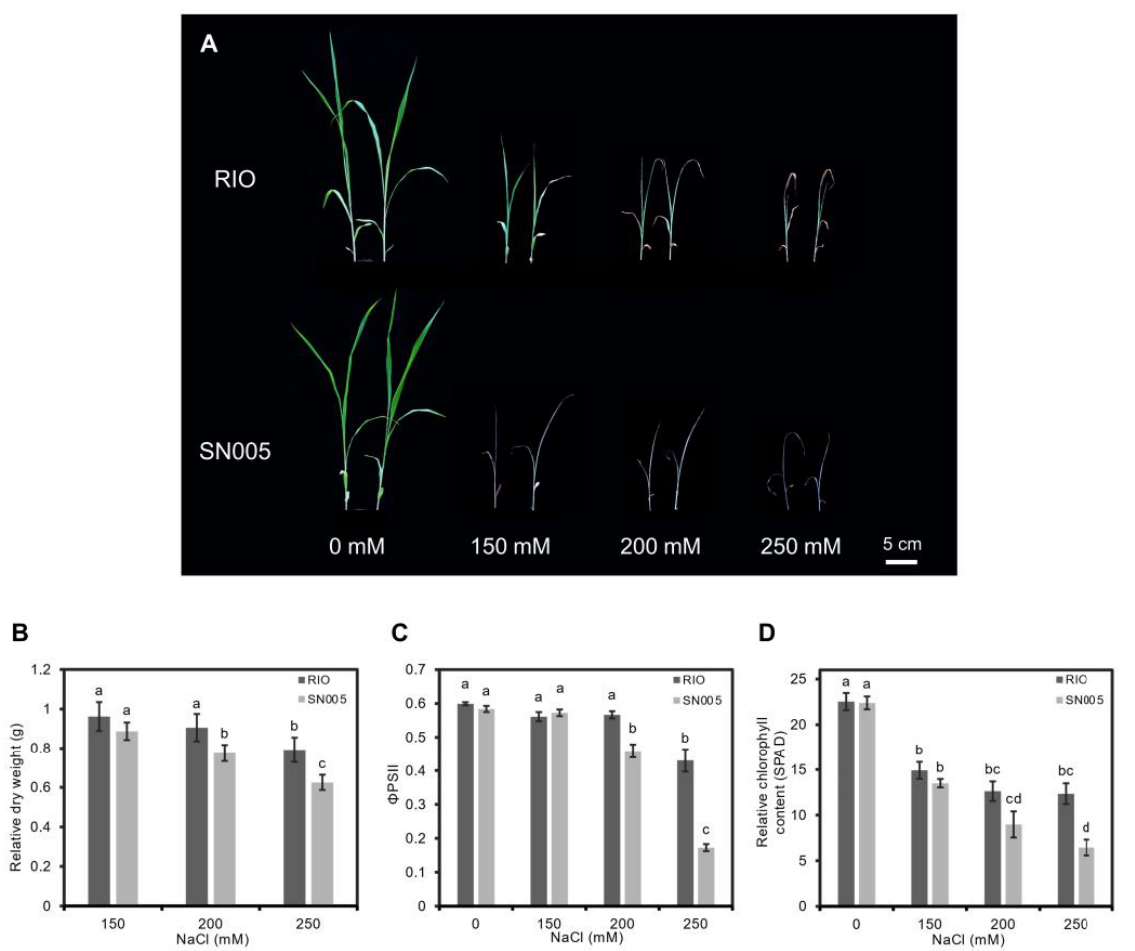
Figure 1. Phenotypic and physiological responses to salt stress in two genotypes with different concentrations of NaCl. ( A ) Phenotype of RIO and SN005 seedlings at 15 days after treatment. ( B ) Relative dry weight at 7 days after treatment. The relative rate was defined as relative dry weight = treatment/control. ( C ) Actual PSII efficiency ( Φ PSII) at 7 days after treatment. ( D ) Relative chloro- phyll content (SPAD) at 7 days after treatment. Values are means ± SE for each measurement. Bars with different lowercase letters are significantly different at p < 0.05 (Duncan’s multiple range test).